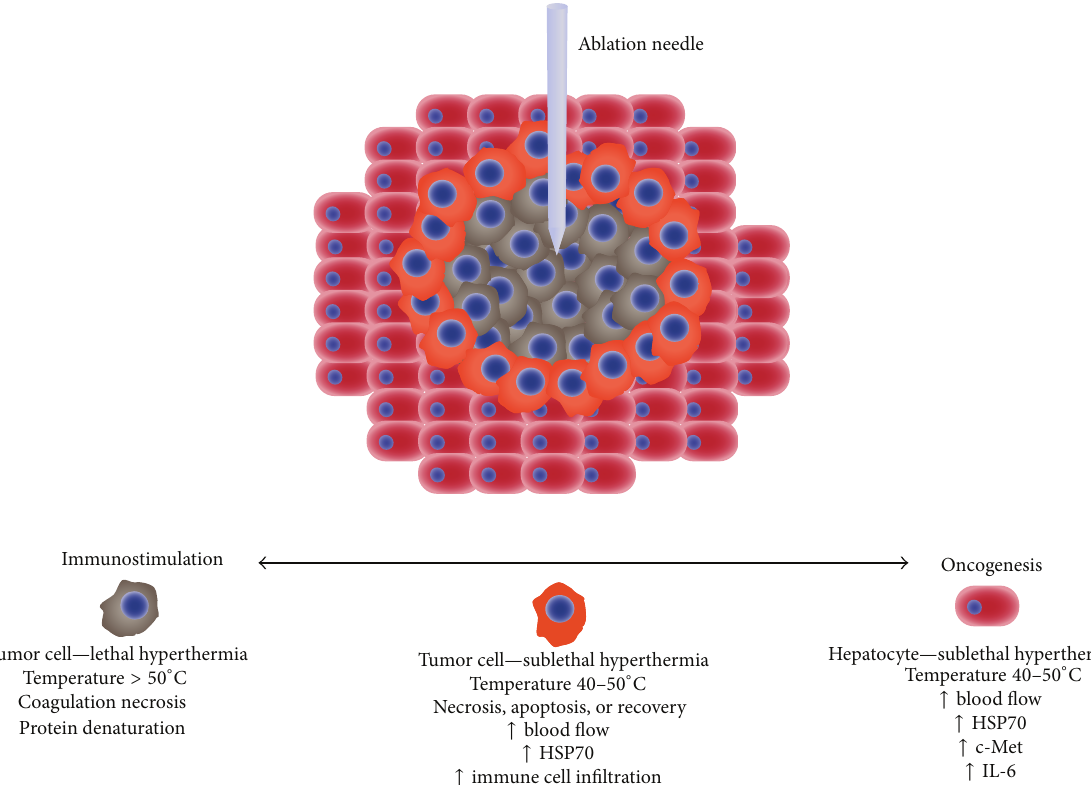
Figure 1: Thermal ablation and the proposed mechanisms for immunostimulation and oncogenesis in the liver. In the central heating zone, temperatures > 50 ∘ C cause coagulation necrosis. In the adjacent peripheral heating zone, lethal hyperthermia temperatures may not be achieved,leadingtoeithernecrosis,apoptosis,orrecovery.Inthiszone,hyperemiaresultsinincreasedoxygendelivery,andcelldeathresultsin the release of cytokines and other immune stimulatory factors such as heat-shock protein 70 (HSP70). As a result, either immunostimulation due to T-cell activation or immunosuppression due to T-cell anergy in the setting of apoptosis may occur. Sublethal thermal injury to the adjacent hepatocytes causes the release of additional growth factors such as c-Met that can cause systemic tumor growth stimulation.